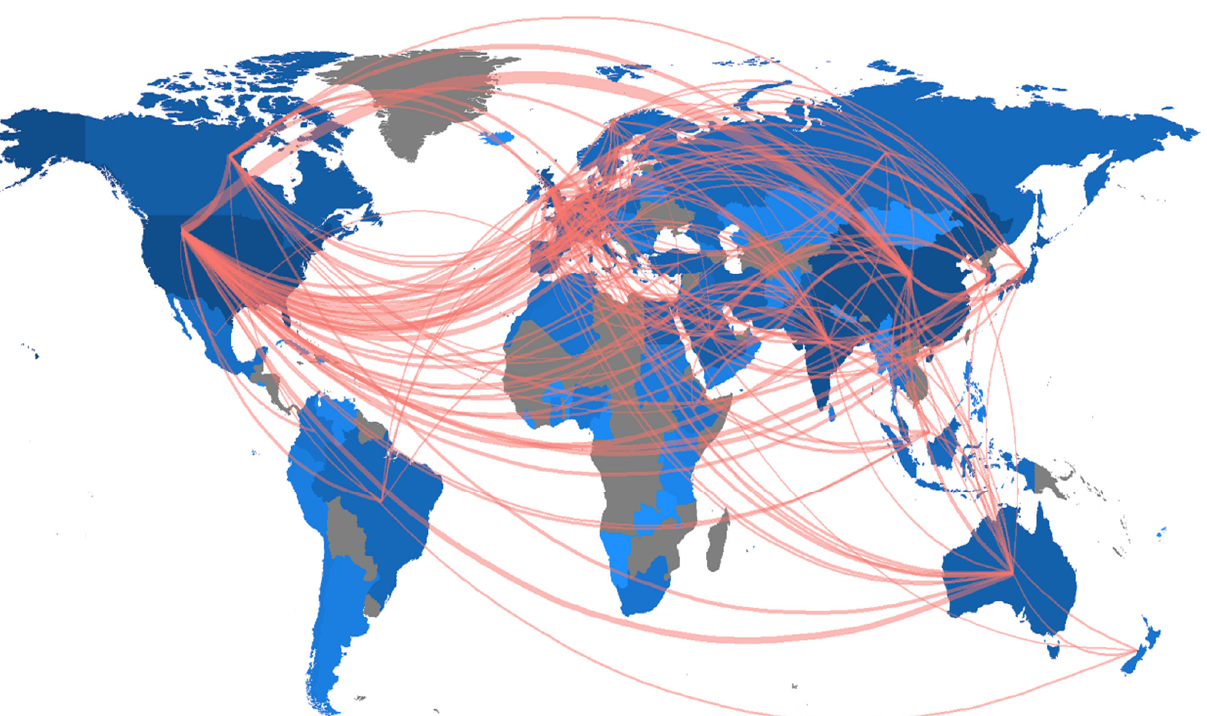
Table 5. Overview of the funding sponsors with the most funded publications.